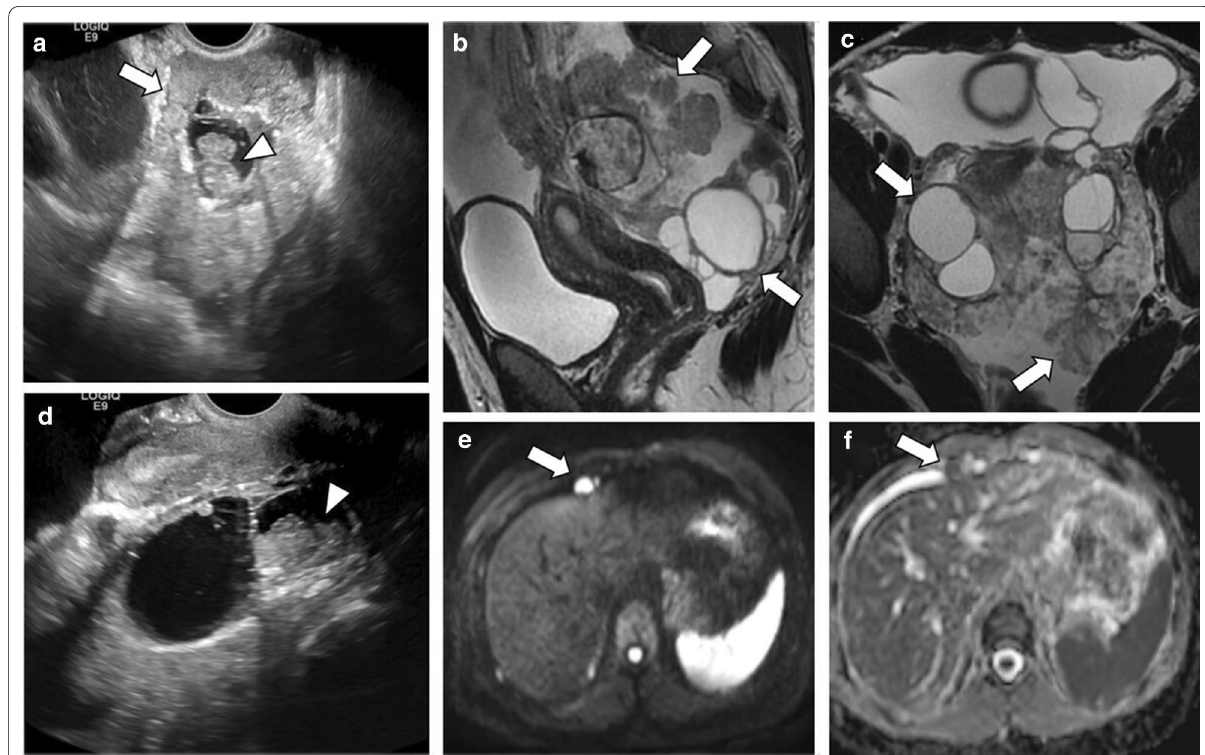
Fig. 3 Bilateral LGSC with SBT and peritoneal metastases in a 25-year-old female. Ultrasound images ( a , d ) reveal a complex mixed tumour with a multinodular aspect involving adnexal structures (arrow). There is fallopian tubes’ dilatation with solid echogenic vegetations inside (arrowheads). Sagittal and axial T2-weighted MR images ( b , c ) demonstrate a bilateral adnexal mixed tumour, with an arborescent growing on the surface of both ovaries (arrows) associated with severe ascites. Axial b -1000 s/mm 2 diffusion-weighted image ( e ) and ADC map ( f ) show diffusion restriction in a perihepatic peritoneal metastasis